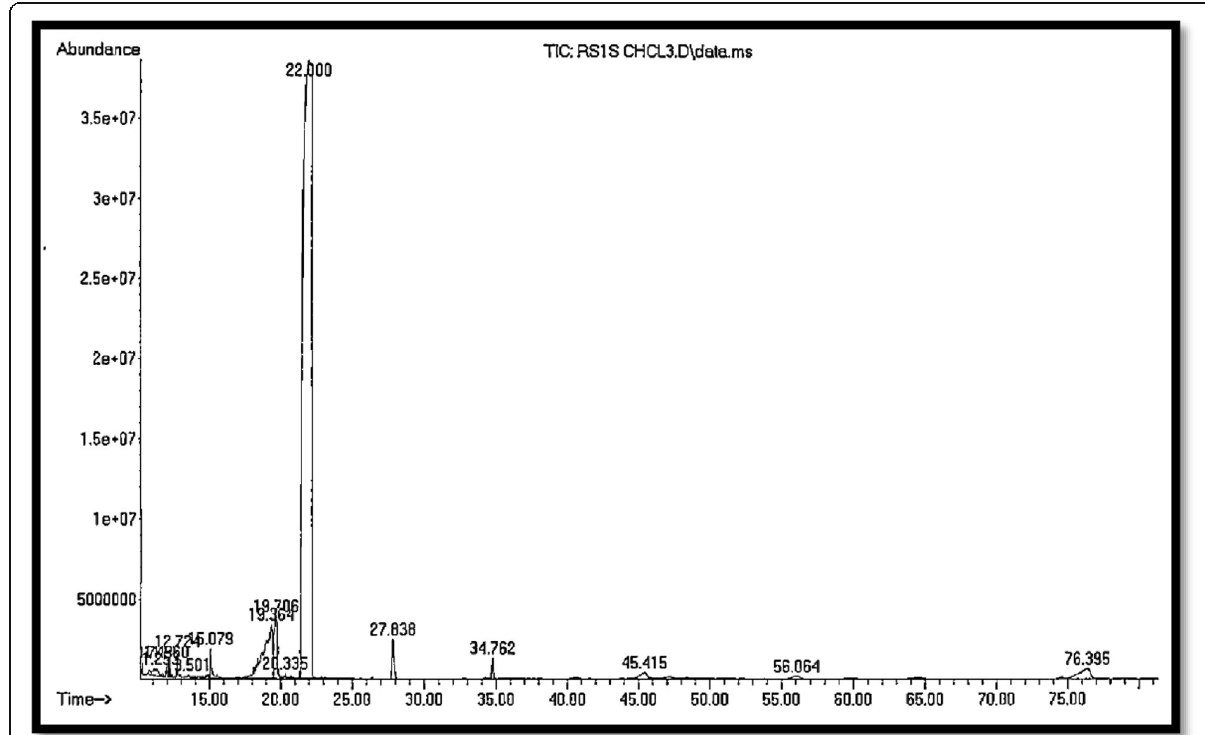
Fig. 11 GC-MS chromatogram of chloroform extract of Rhazya stricta stems (RS1S